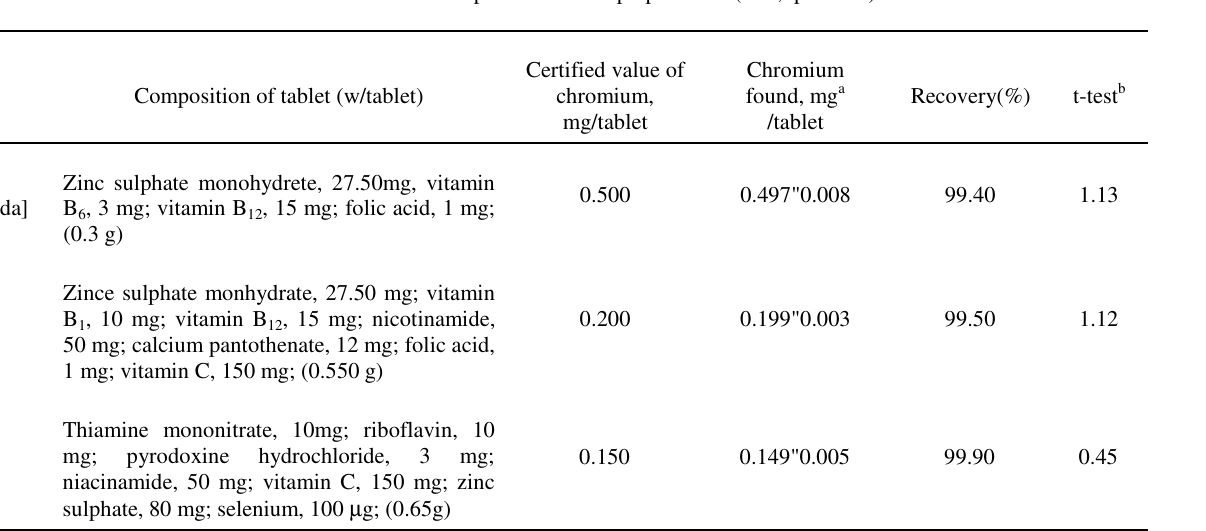
Table. 4 . Determination of chromium in pharmaceutical preparations (n=5; p =